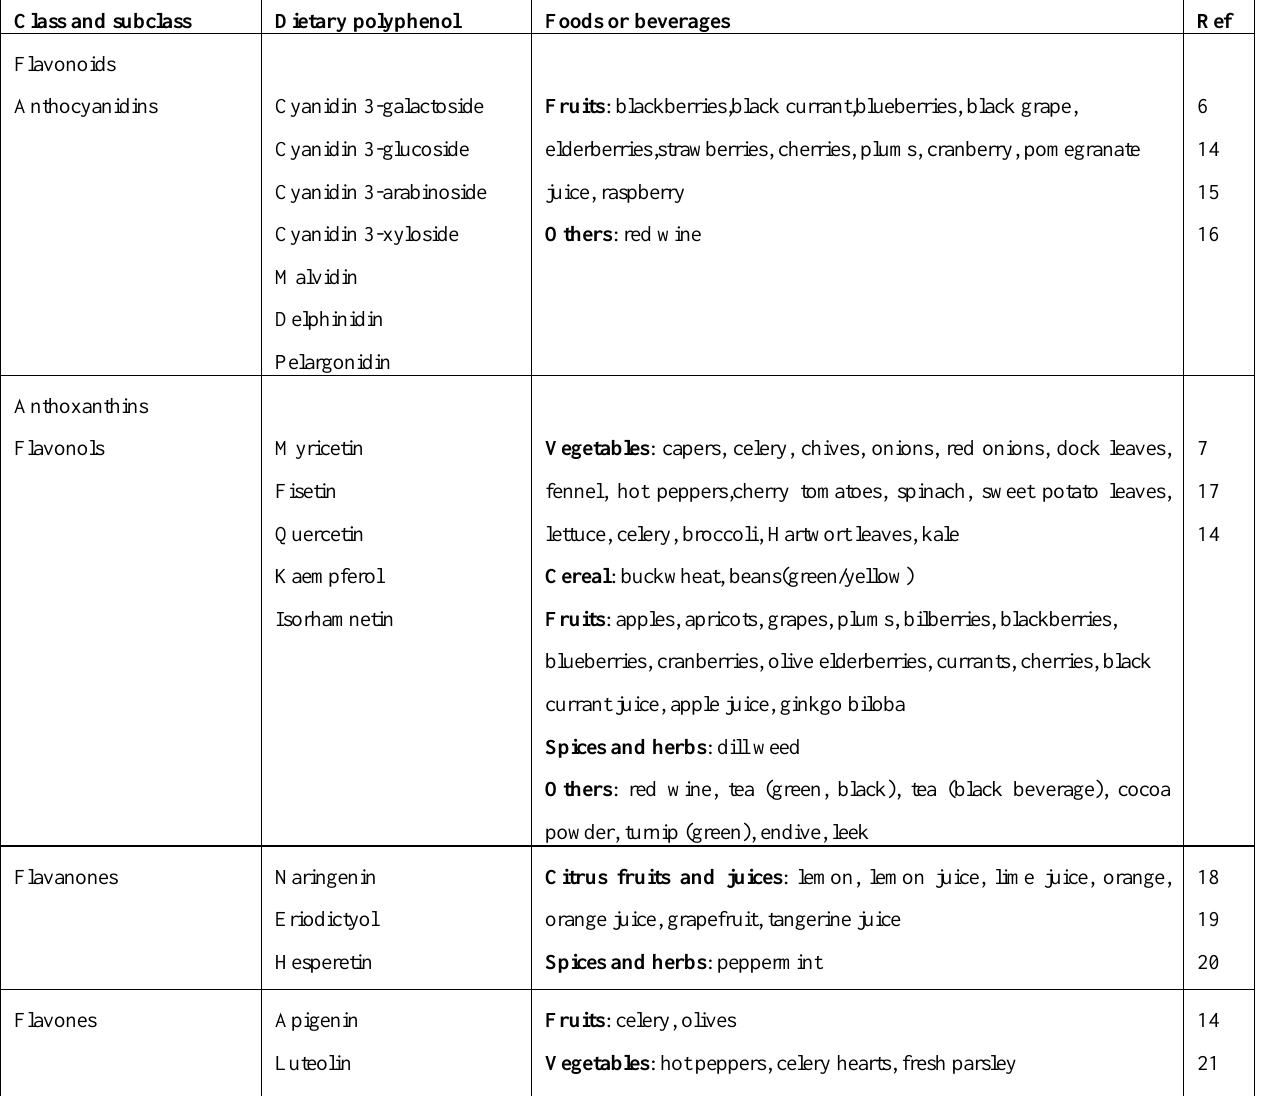
Table 1. Classification and sources of dietary